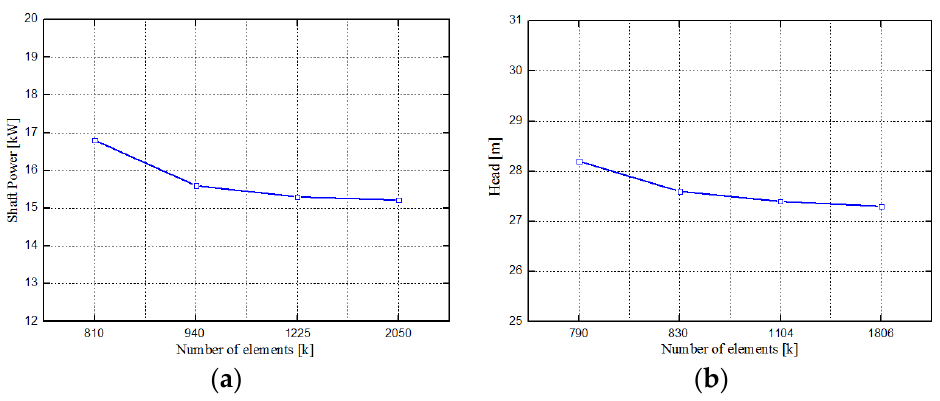
Figure 4. Mesh independence analysis. ( a ) Turbine section. ( b ) Pump section.